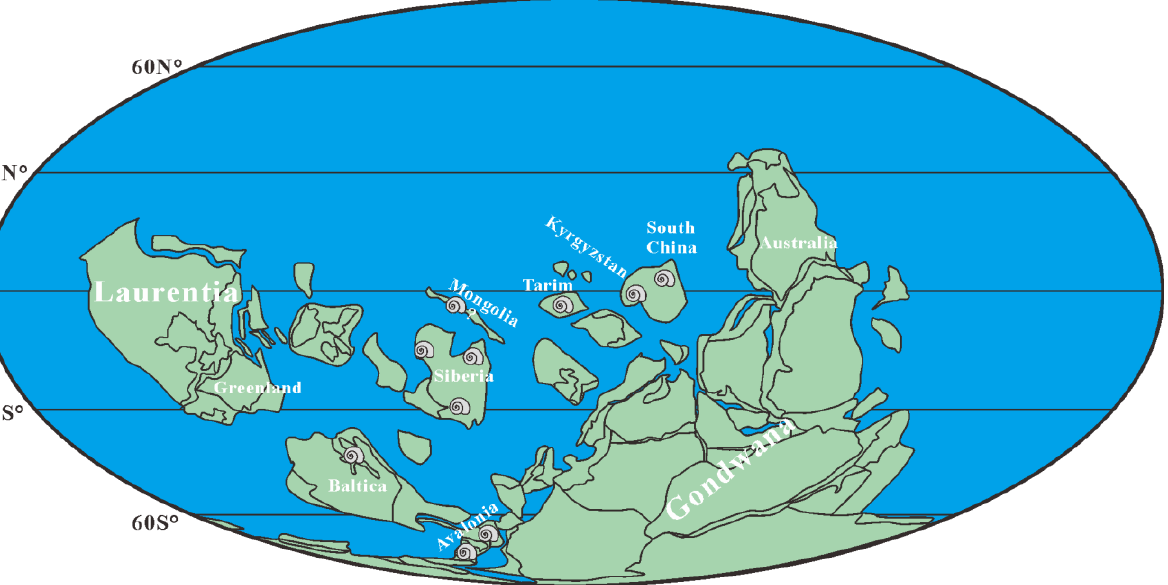
Figure 7. Paleogeographical distribution of Aldanella attleborensis from Cambrian Stage 2. Paleogeo- graphic map modified from [98] and [20]; the distribution data from [9,13,21,33,39,40,49,99,100] and herein.